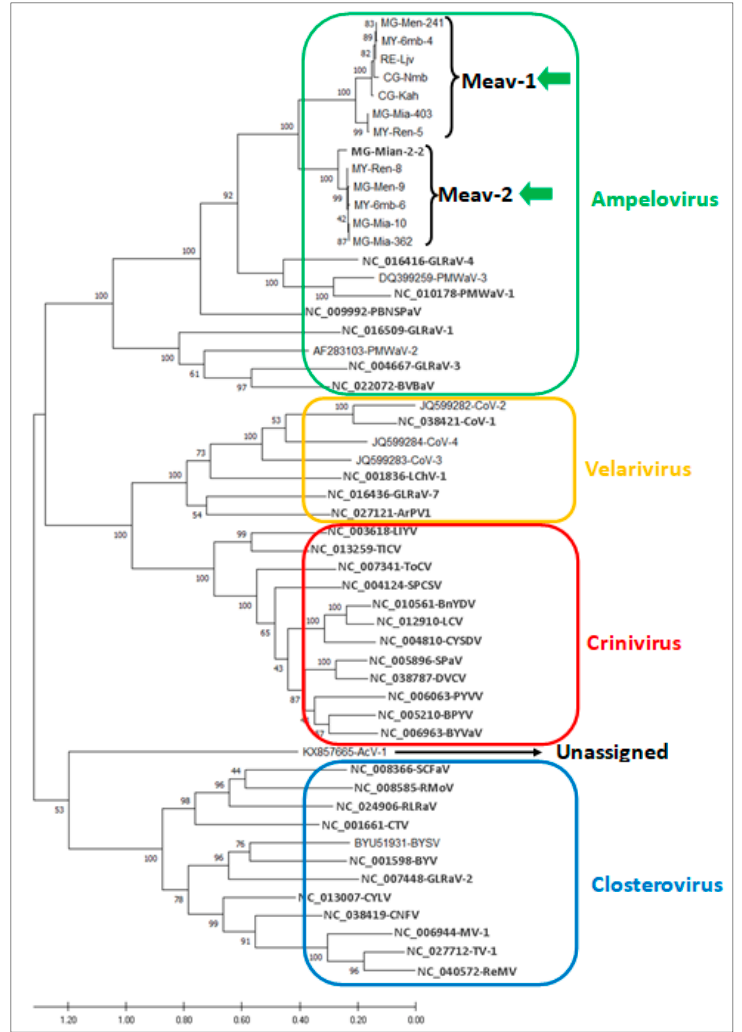
Figure 2. Phylogenetic analysis of the aligned amino acid sequences of the HP70h (ORF3) of the thirteen isolates from cassava and of selected members of the family Closteroviridae (see the Sup- plementary Material Table S2 for detailed information on these viruses). Green arrows indicate isolate sequences obtained in this study. Maximum likelihood phylogenetic tree was reconstructed in Mega X using Poisson model with uniform distribution for amino acid sequence alignments. Bootstrap values are indicated at the main branch nodes. The bar represents the number of amino acid substitution per site.